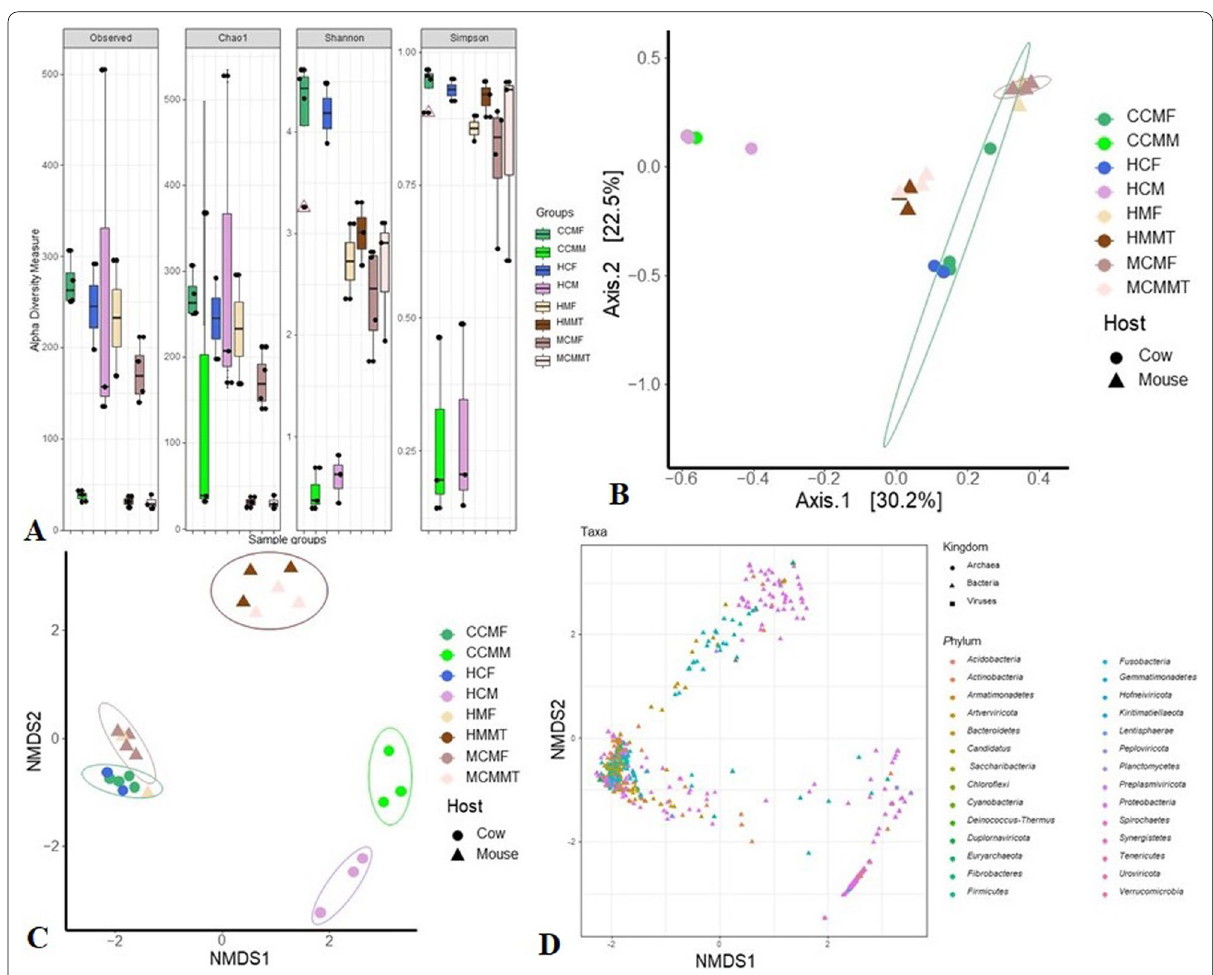
Fig. 2 Microbiome diversity and composition in CM and H samples of cows and mice after FMT (fecal microbiota transplantion) and MMT (milk microbiota transplantion). A Alpha diversity measures with Observed, Chao1, Shannon and Simpson indices to visualize the difference in microbiota structure in fecal, milk and mammary tissues of cows and mice. B Principal coordinate analysis (PCoA) plot (measured on the Bray–Curtis distance method) showing significant microbiome diversity in different hosts i.e., cows and mice ( p 0.005, Kruskal–Wallis test) and sample groups = ( p 0.001, Kruskal–Wallis test). C Non-metric multi-dimensional scaling (NMDS) plot (measured with Weighted-UniFrac method) representing = significant microbial beta diversity in different hosts (cows and mice) ( p 0.005, Kruskal–Wallis test) and sample groups ( p 0.001, Kruskal–Wallis = = test). D NMDS plot showing phylum level microbiome (archaea, bacteria and viruses) diversity in all samples of the study metagenomes. The sample groups are- CCMF: cows clinical mastitis feces; HCF: healthy cows feces; CCMM: cows clinical mastitis milk; HCM: healthy cows milk; MCMF: mouse clinical mastitis feces; HMF: healthy mouse feces; MCMMT: mouse clinical mastitis mammary tissue; and HMMT: healthy mouse mammary